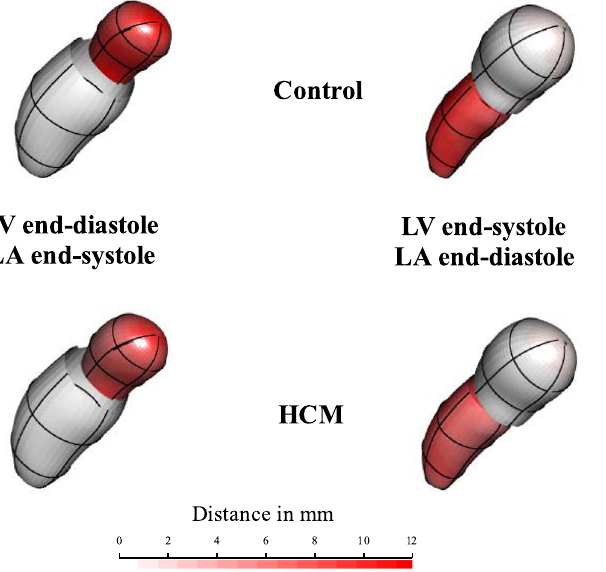
Figure 1. Global deformational patterns in Control and HCM. The colormap ranges from white (min) to red (max) and refers to |x M − x|, with x M the position of a point in the LV or LA diastole and x the position of the corresponding deformed state. This was done here just for sake of visualization as the Common Template from which deformation were computed was chosen in correspondence of the Grand Mean of all time frames of all cardiac cycles instead that in correspondence of a particular deformed/undeformed state. See text for further explanation. Supplementary Figure S1 shows the corresponding animation in full color using blue-cyan-yellow- red color